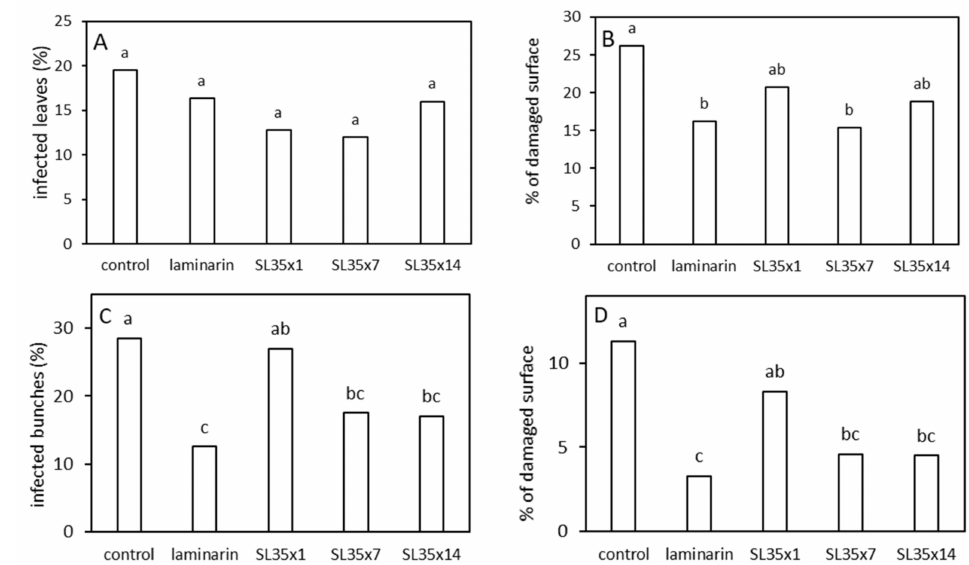
Figure 4. Effects of SL35 treatments on incidence ( A ) of downy mildew on grapevine (field trial, notation 18 June 2020) expressed as % of infected leaves and on severity ( B ) expressed as % of damaged surface (notation 30 June 2020). The same parameters were measured on bunches: in- cidence ( C ) and severity ( D ) (notation 4 June 2020). SL35 was applied at different concentrations (50 mg L − 1 for SL35x1, 350 mg L − 1 for SL35x7, 700 mg L − 1 for SL35x14) beginning from May 5 and repeated at 7-12-day intervals (see Table 2 for details). Control corresponds to water treatment. Laminarin corresponds to application of IODUS 2 CEREALES ® . Means followed by the same letter do not significantly differ ( p < 0.05, one-way ANOVA followed by Newman and Keuls test and Kurtosis